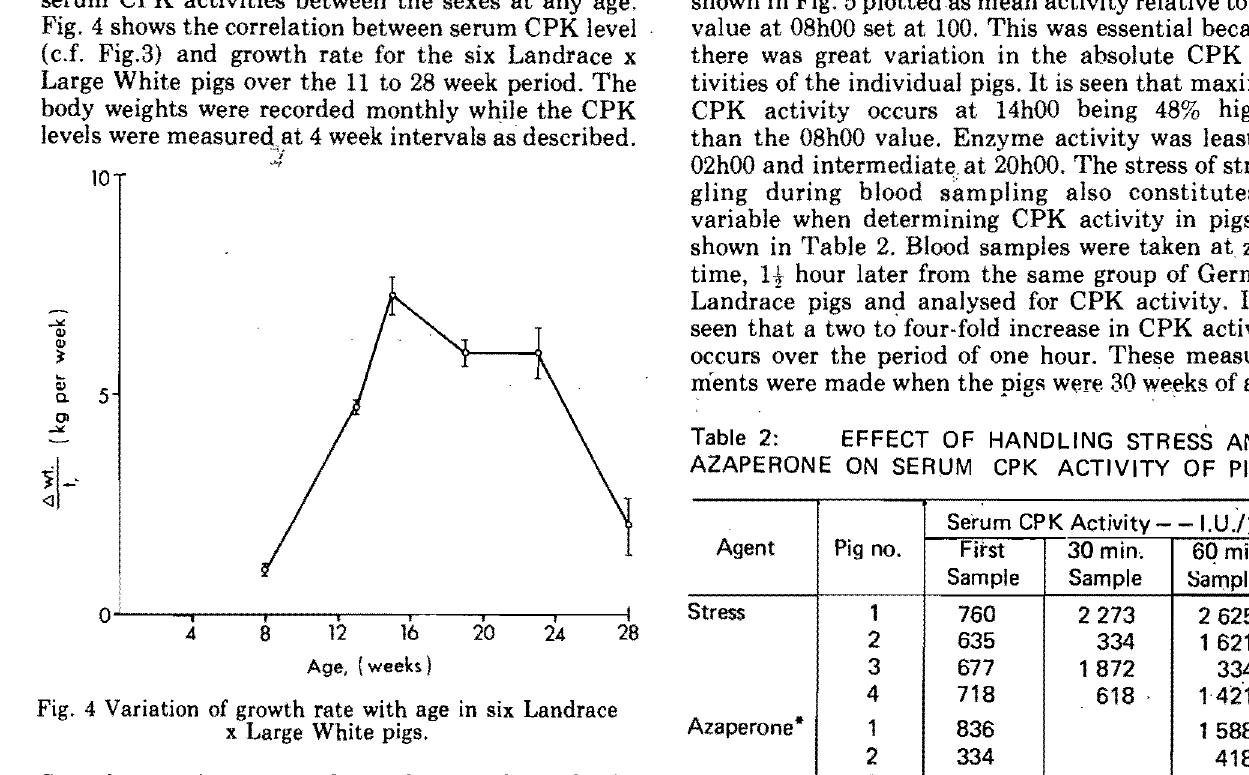
Fig. 4 Variation of growth rate with age in six Landrace x Large White pigs.